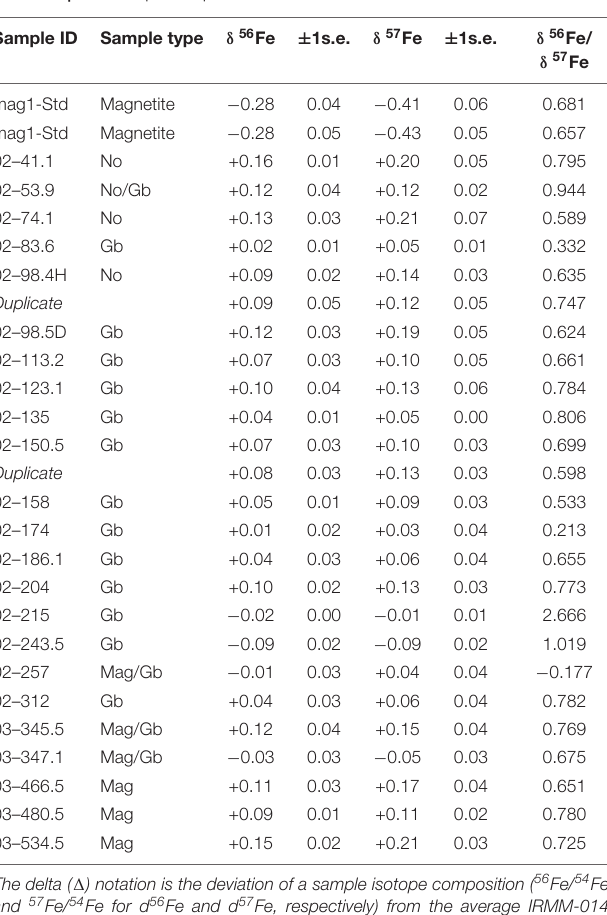
TABLE 1 | Iron isotope composition of Windimurra cumulate rocks.